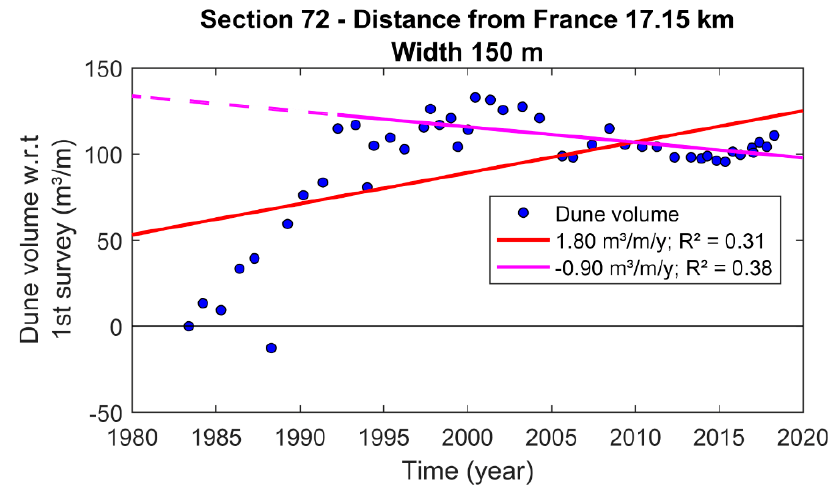
Figure 16. Decadal dune evolution of the coastal dunes at section 72. The solid magenta line indicates the recent dune trend.